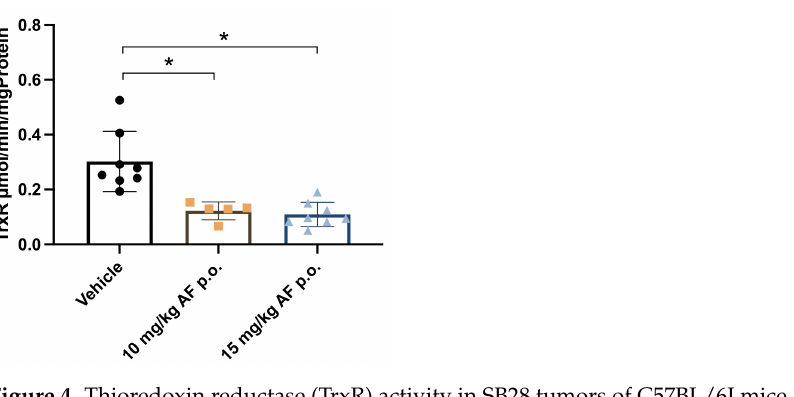
Figure 4. Thioredoxin reductase (TrxR) activity in SB28 tumors of C57BL/6J mice after oral adminis- tration of AF. TrxR activity in SB28 tumors isolated from mice after 14 days of daily oral AF treatment. Data represent mean ± SD. N = 5–8 mice per group. * p < 0.05 compared to vehicle